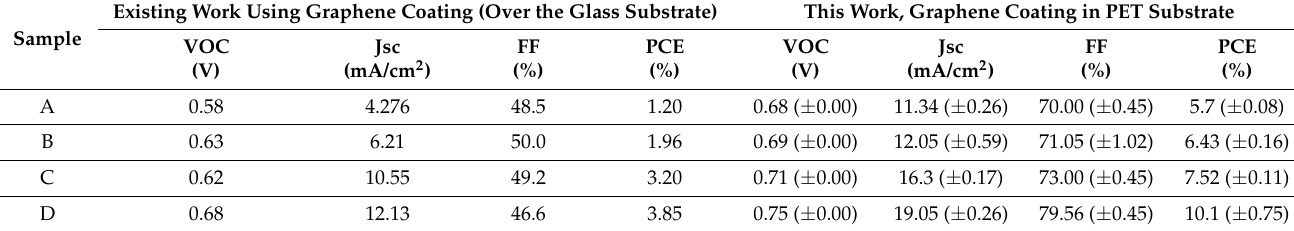
Table 4. Comparison of NPD performance parameters for various